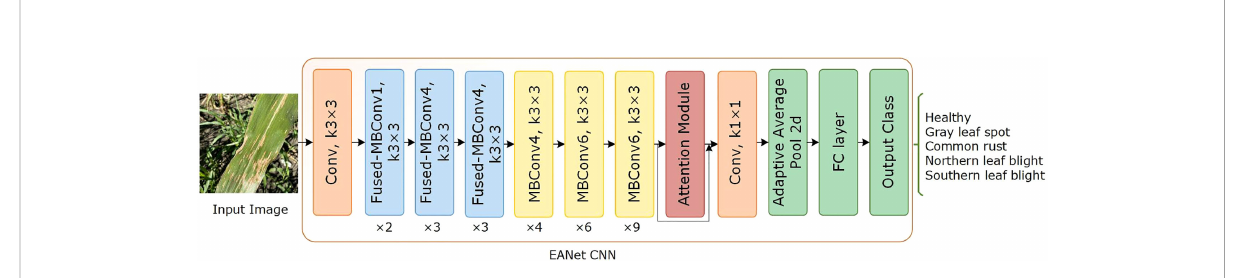
FIGURE 4 Architecture of proposed EANet model for the classi fi cation of maize leaf